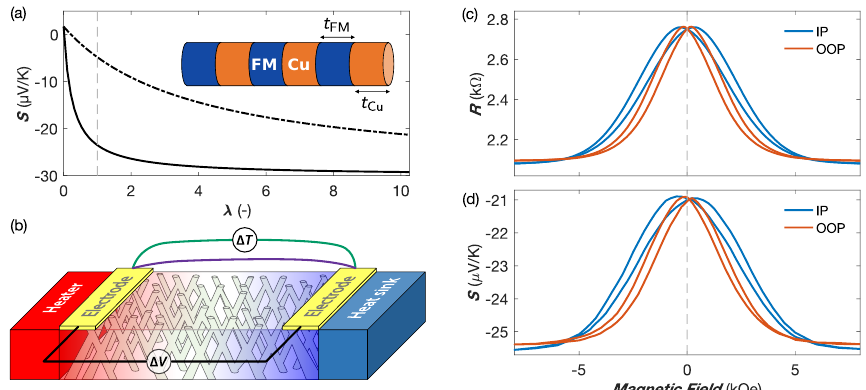
Figure 13. ( a ) calculated thermopower for Co/Cu multilayers in the layer parallel (dash-dotted line) and perpendicular (solid line) directions vs thickness ratio λ = t FM /t Cu using Equations (7) and (8), and bulk values for S Co , ρ Co , S Cu and ρ Cu . The grey dashed line shows the values for λ = 1. The inset shows a FM/Cu multilayer stack; ( b ) experimental set-up for Seebeck coefficient and the magneto-thermoelectric effect measurements. The color represents the generated temperature profile in the NW networks; ( c , d ) Electrical resistance ( c ) and Seebeck coefficient ( d ) of a Co/Cu NW network (80 nm in diameter and 3% packing density) at room temperature. The curves in ( c , d ) were obtained with the applied field in-plane (IP—in blue) and out-of-plane (OOP—in red) of the NW network film (adapted from [65]). Figure adapted from ref. [65] with permission of the